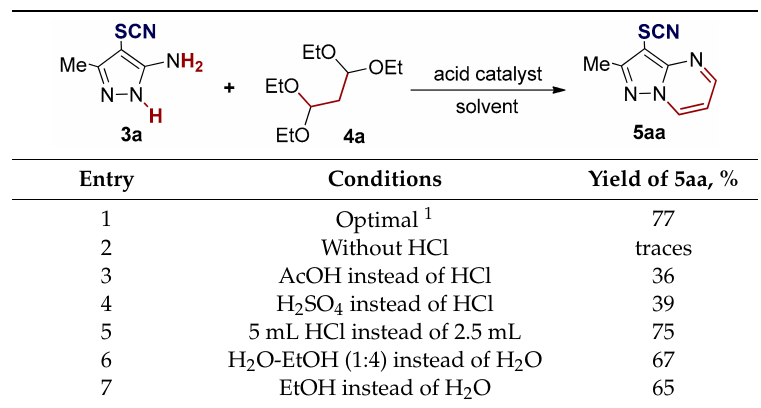
Table 3. E ff ect of the condensation conditions on the yield of the target product 5aa .